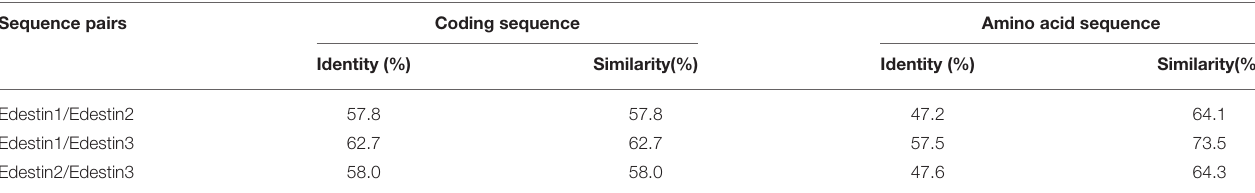
TABLE 3 | Percentage of sequence similarity of coding sequences (CDS), amino acid sequences of edestins. Sequence pairs Coding